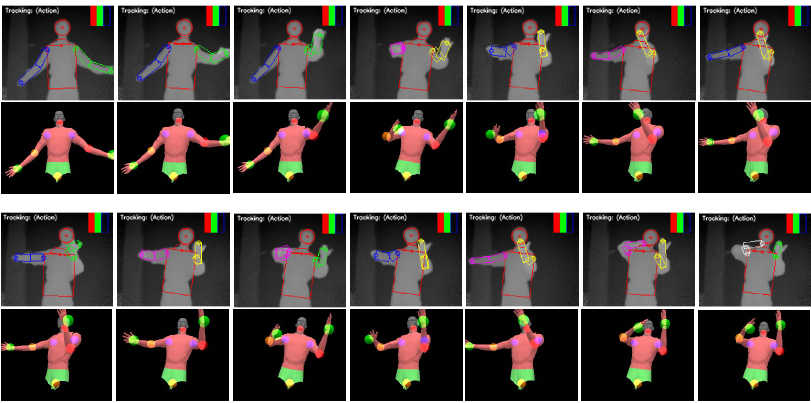
Figure 7. Upper body pose tracking for violin playing motion. Rows 1 and 3: depth image sequence with the detected body parts. Rows 2 and 4: corresponding reconstructed